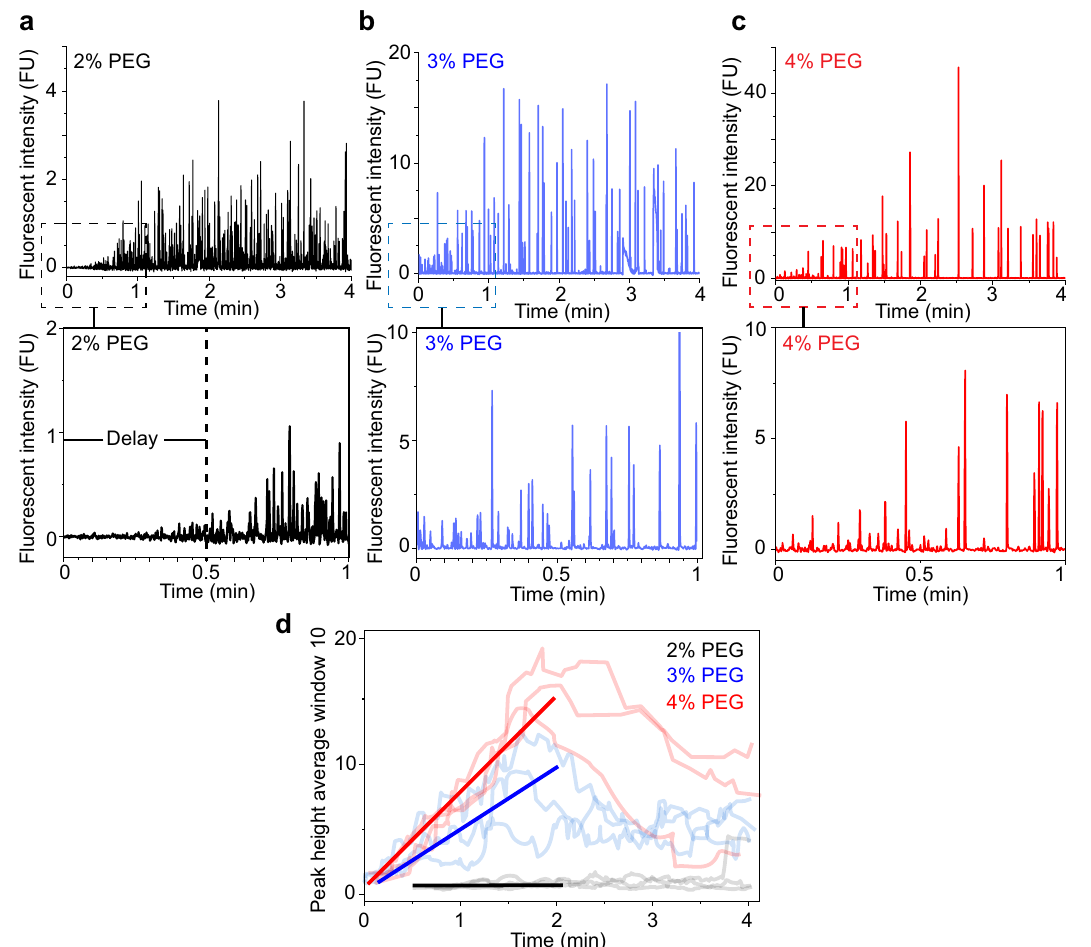
Fig. 3 Droplet formation kinetics of 50 µ M Ddx4n1 as a function of PEG3000 concentration. a (Upper panel) Peak intensity development of 50 µ M Ddx4n1 and 2% (w/v) PEG3000 for 4 min of recording time is shown. (Lower panel) Peak intensity development of 50 µ M Ddx4n1 and 2% (w/v) PEG3000 from 0 to 1 min of recording time depicts the 30 s delay in the formation of droplets. b (Upper panel) Peak intensity development of 50 µ M Ddx4n1 and 3% (w/v) PEG3000 for 4 min of recording time is shown. (Lower panel) Peak intensity development of 50 µ M Ddx4n1 and 3% (w/v) PEG3000 from 0 to 1 min of recording time depicts no delay in the formation of droplets. c (Upper panel) Peak intensity development of 50 µ M Ddx4n1 and 4% (w/v) PEG3000 for 4 min of recording time is shown. (Lower panel) Peak intensity development of 50 µ M Ddx4n1 and 4% (w/v) PEG3000 from 0 to 1 min of recording time depicts no delay in the formation of droplets. However, the peaks are substantially higher under this condition compared to 2 and 3% (w/v) PEG3000. d Peak intensity development with an averaging window of 10 peaks of 2% PEG3000 (black), 3% PEG3000 (blue) and 4% PEG3000 (red) is shown. The solid lines are linear fi ts of the peak heights obtained from three independent observations for each sample (Ddx4n1 in the presence of 2, 3, and 4% (w/v) PEG3000) from 0 to 2 min. The experiments are performed three times with similar observations. Source data are provided as a Source Data fi